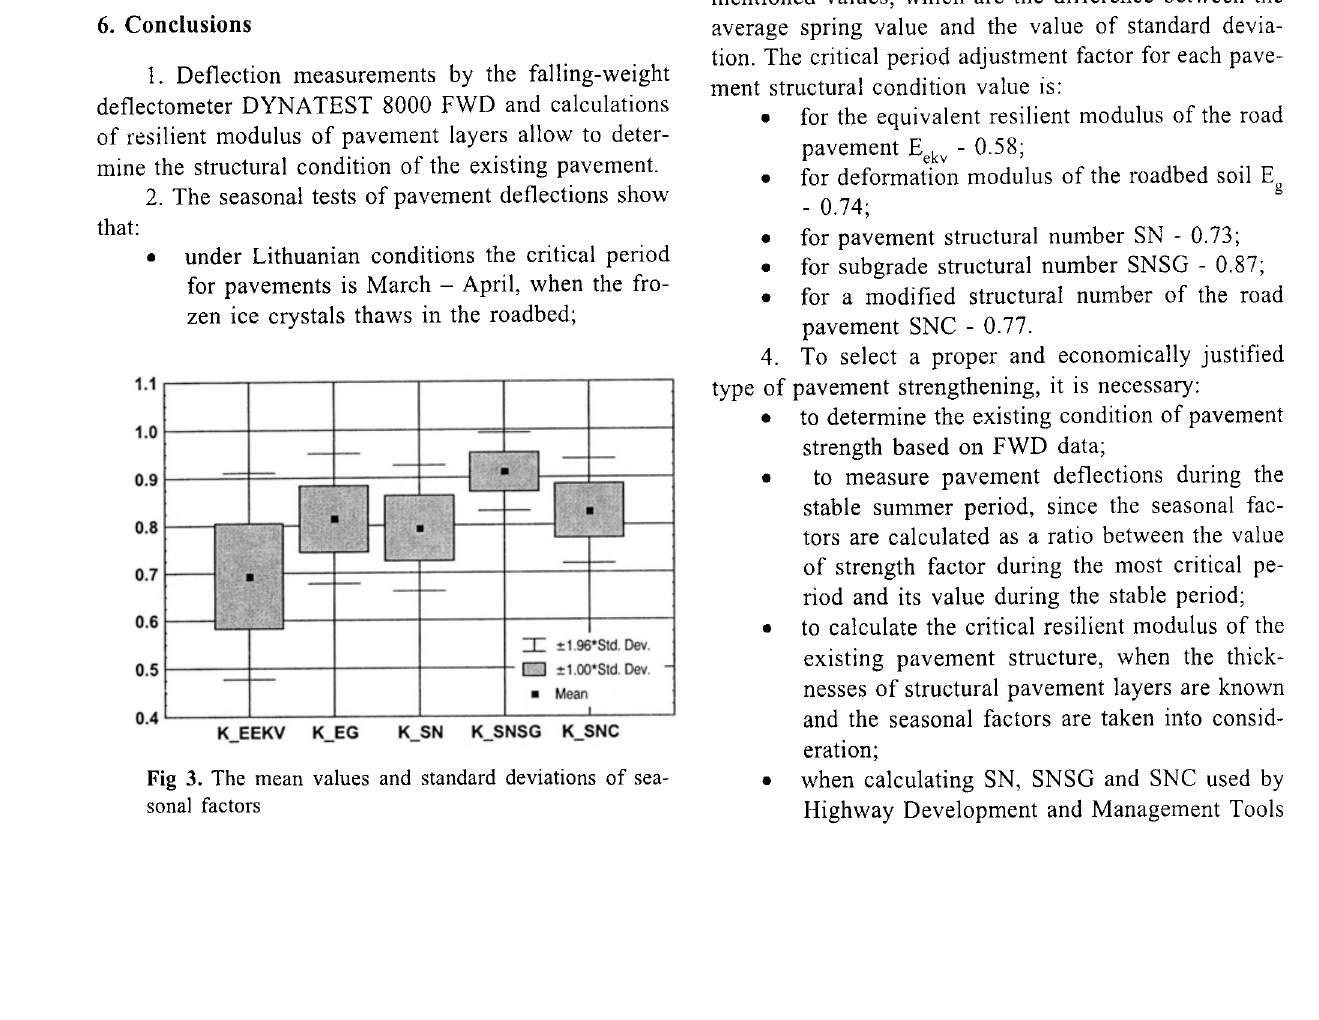
Fig 3. The mean values and standard deviations of sea sonal